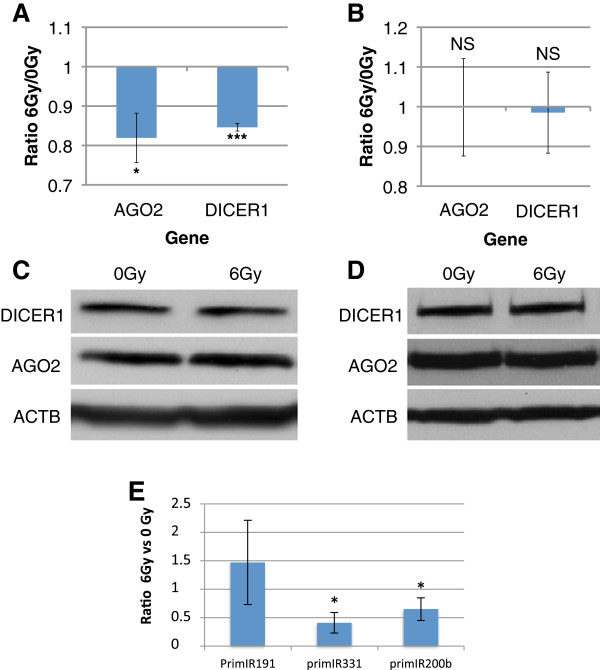
Impact of ionizing radiation on the miRNA biogenesis pathway. The radiation-response of AGO2 and DICER, that are involved in the late steps of the miRNA processing pathway, was assessed at the mRNA and protein levels. AGO2 and DICER1 mRNA expression 3 h after 6-Gy irradiation in proliferating (A) and differentiated keratinocytes (B) addressed by RT-QPCR (n=3; error bars represent SD; bilateral paired t-test : *p≤0.05, ***p≤0.001, NS: Non-significant). AGO2 and DICER1 protein level 3 h after 6-Gy irradiation in proliferating (C) and differentiated keratinocytes (D) addressed by immunoblotting. ACTB (Actin B) was used as loading control. (E) The expression of the primiR-191, primiR-200b and primiR-331 was assessed by quantitative qRT-PCR in proliferating keratinocytes 3 hours after 6 Gy-irradiation. Values are mean fold changes +/− SD of independent experiments performed in triplicate on keratinocytes from 3 different donors (bilateral paired t-test: *p≤0.05).